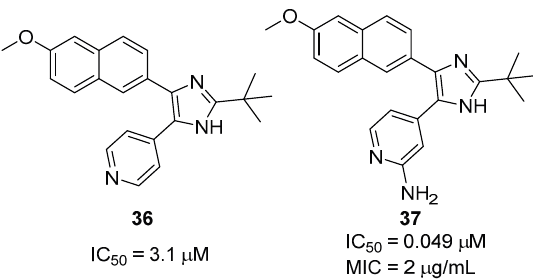
Figure 11. Structure and Mt GS inhibitory activity of the 2,4,5-trisubstituted imidazoles 36 and 37